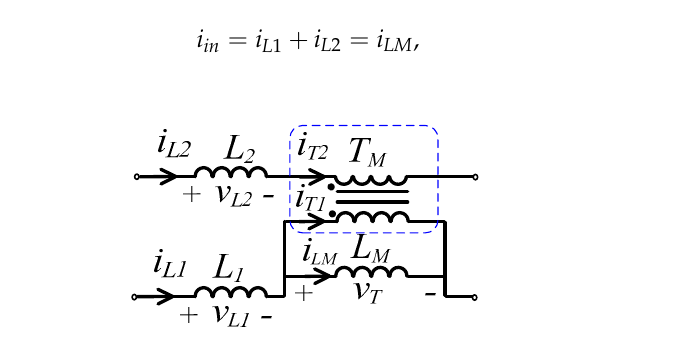
Figure 3. Equivalent circuit for the coupled inductor.